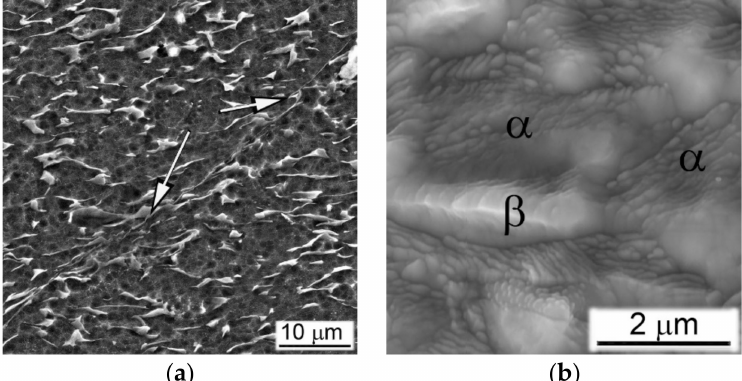
Figure 12. Microstructure of the non-cracked Ti64GL specimen after the quasi-static test at the strain rate of 0.001 s − 1 : ( a )—zone II, ( b ) zone IV. SEM, SE. Arrows in ( a ) indicate a slip localization